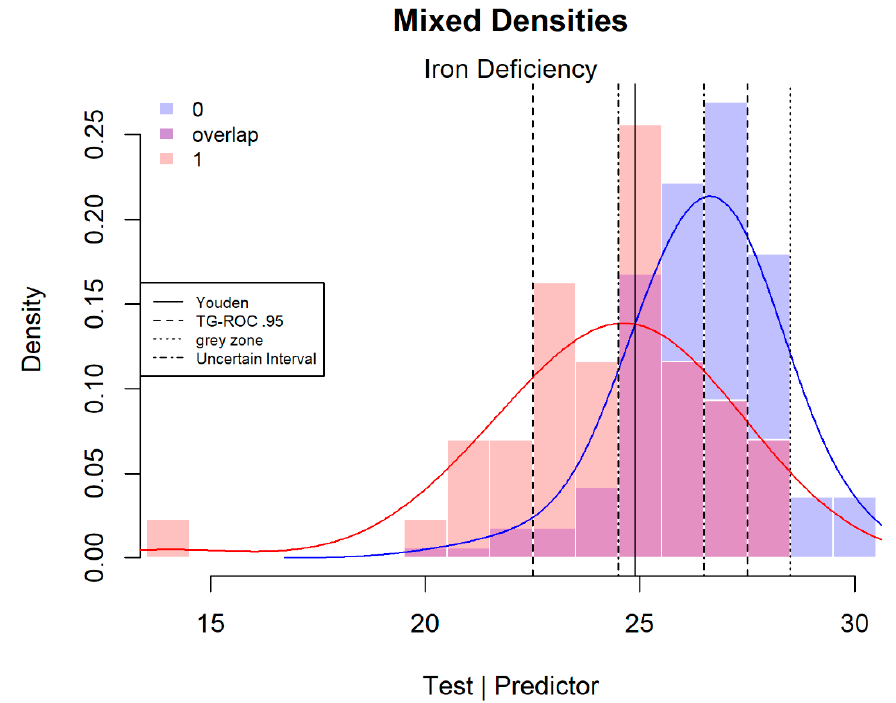
Figure 1. Overlapping test results: mixed densities of reticulocyte haemoglobin content (Chr) in children with ( n = 43) and without iron deficiency ( n = 167). The test has a C-statistic (or AUC, area under the curve) of 0.78. Data published in [18]. The lower limits of the two graphs receiver operating characteristics (TG-ROC) and grey zone methods coincide.